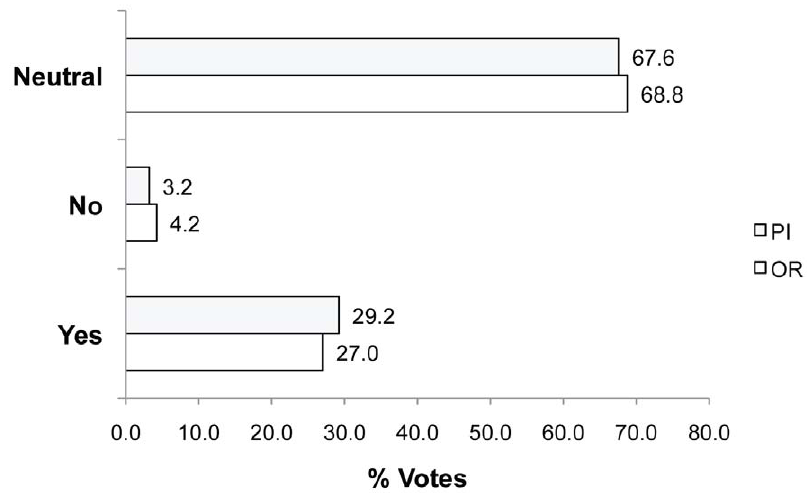
Figure 7. Percent of Yes, No and Neutral votes in response to Q5. Question 5: Should animals be re-used in research protocols?